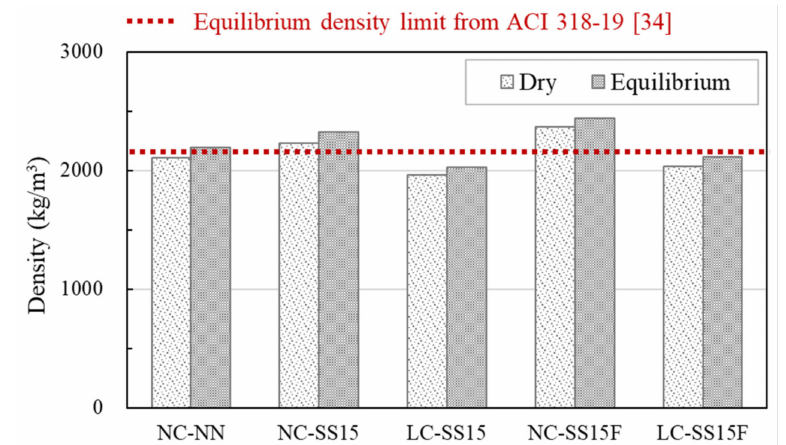
Figure 5. Test results of concrete